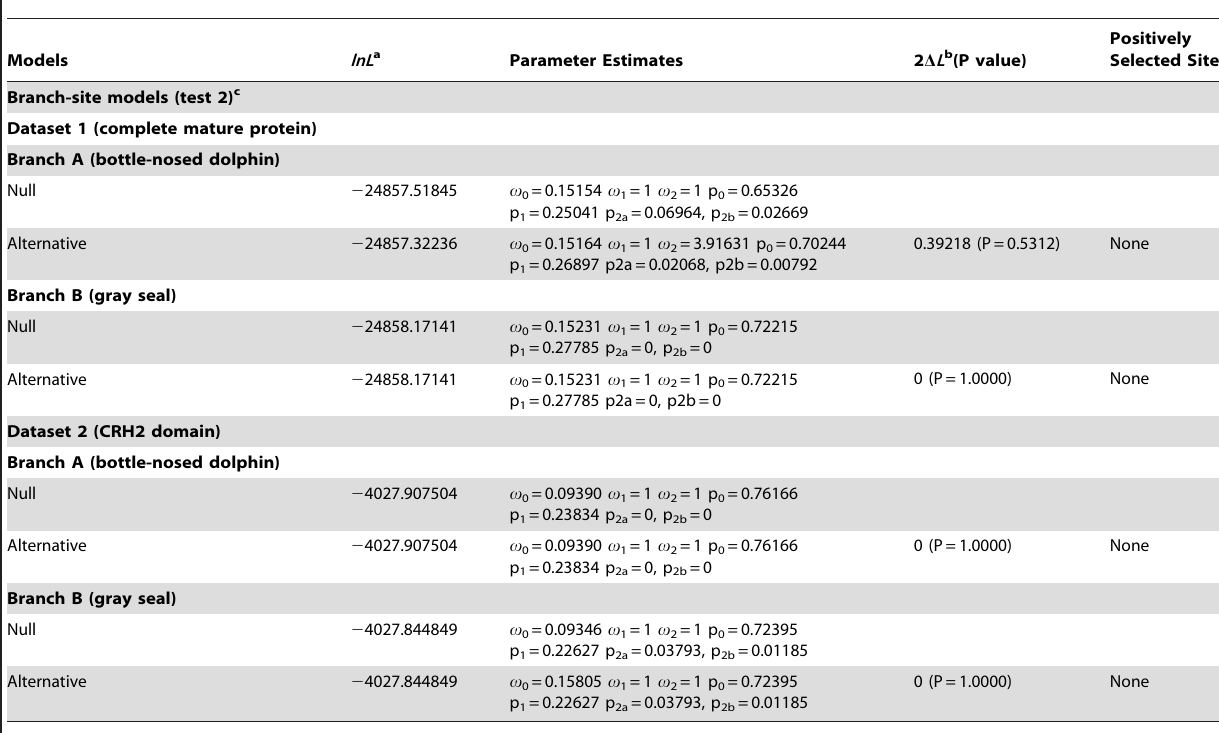
Table 2. PAML analyses for leptin receptor ( LPR )